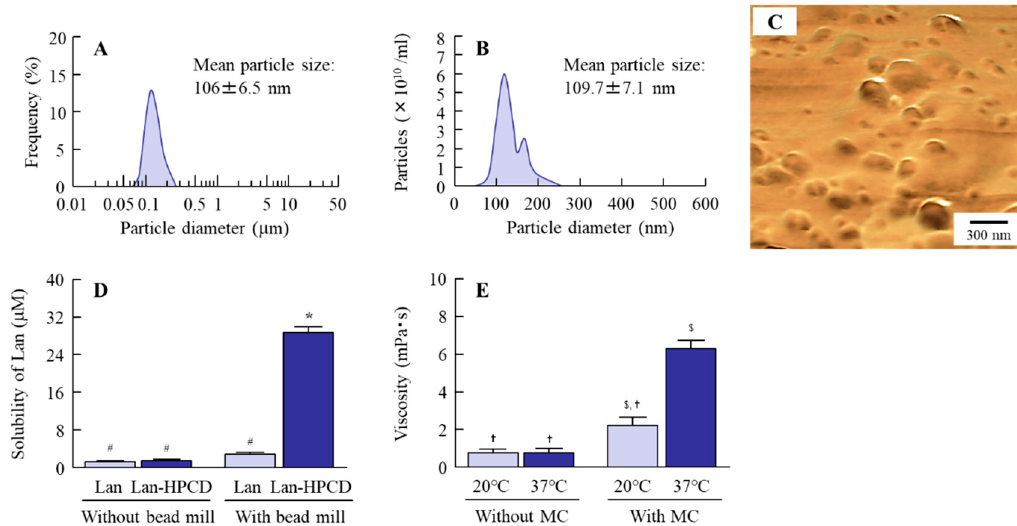
Figure 1. Evaluation of drug particle size, solubility, and viscosity in ophthalmic in situ gel formulations containing lanosterol (LA-NPs/ISG). ( A , B ) Particle size distribution of lanosterol (Lan) in LA-NPs/ISG using the SALD-7100 ( A ) and NANOSIGHT LM10 ( B ). ( C ) Atomic force microscope (AFM) image of Lan in LA-NPs/ISG. ( D ) Solubility of Lan in LA-NPs/ISG with or without 2-hydroxypropyl- β -cyclodextrin (HPCD). ( E ) Viscosity of ophthalmic Lan formulations with or without methylcellulose (MC) at 20 °C and 37 °C. n=12. * p < 0.05, vs. Lan without bead mill. # p < 0.05, vs. Lan-HPCD with bead mill. $ p < 0.05 vs. 20 °C without MC. ✝ p < 0.05 vs. 37 °C with MC. The bead mill treatment decreased the particle size of Lan to nano-size and increased the Lan/HPCD inclusion. The ratio of undissolved drug Lan was 99.8% in the 0.5% LA-NPs/ISG. The viscosity of LA-NPs/ISG was enhanced under the 37 °C condition.